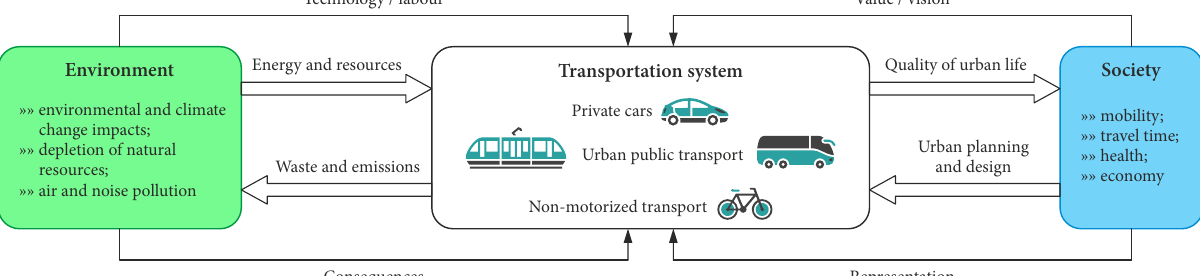
Figure 1. Interaction of transport system with environment and